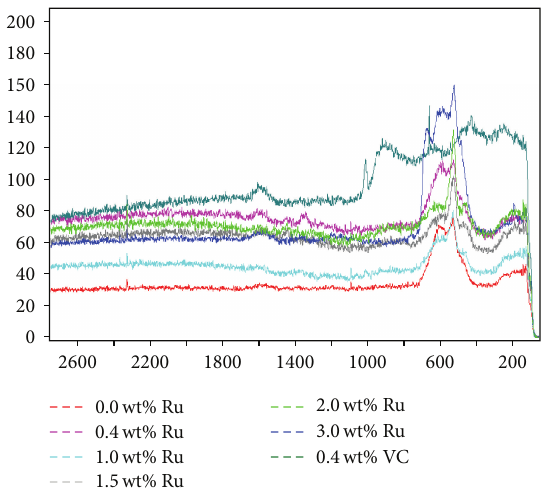
Figure 10: Raman spectra of selected alloys after exposure to synthetic mine